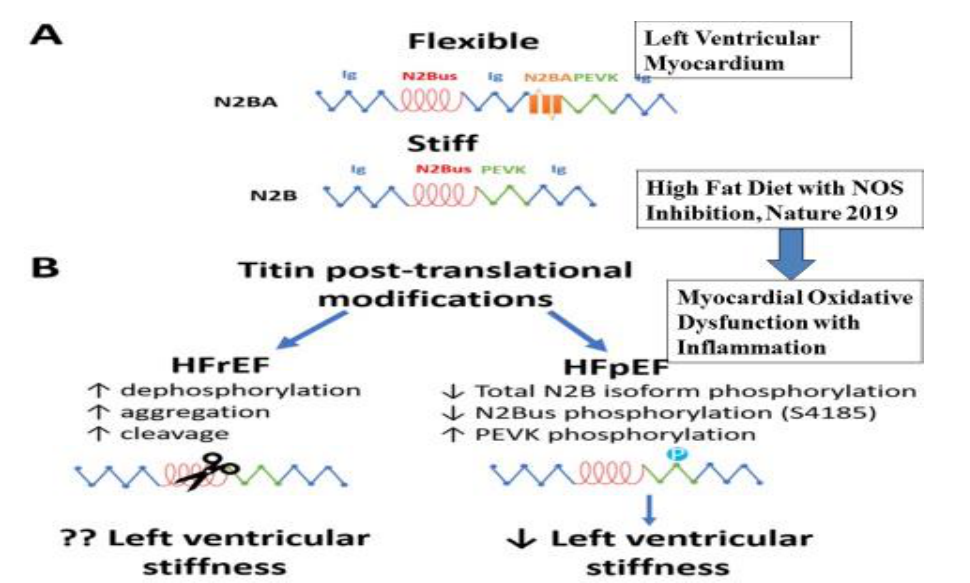
Figure 2. Myocardial oxidative dysfunction due to high-fat diet causing nitric oxide synthase (NOS) inhibition leading to heart failure with preserved ejection fraction (HFpEF). ( A ) Alternative isoforms of titin in Left Ventricular Myocardium. ( B ) Post-translational modifications of Titin and their effect on left HFrEF and HFpEF (Adapted from Reference [23] Simmonds, SJ, et al., Cells.2020;9:242.10.3390/cells9010242, under liscence http://creativecommons.org/licenses/by/4.0/, accessed 15 June 2022). Table 2. Antioxidant defences and antioxidants available in the HEART